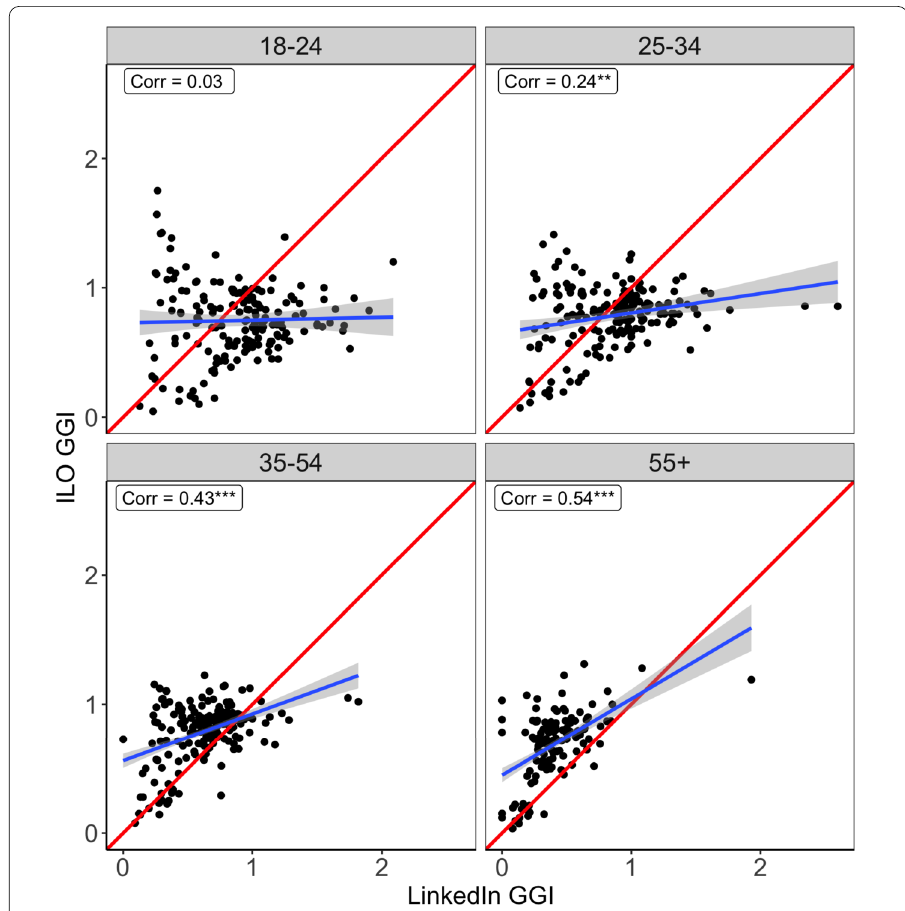
Figure 5 Scatter plot of age-specific LinkedIn GGI ( x -axis) and ILO GGI ( y -axis)